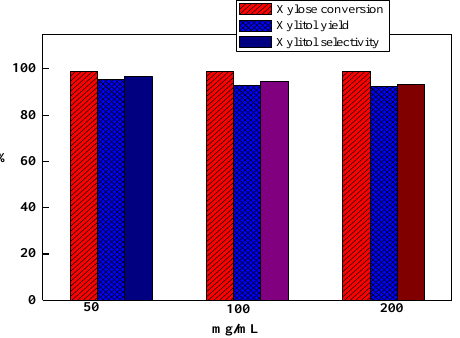
Figure 7. Effect of xylose concentration on the conversion of xylose, the xylitol yield, and the selectivity toward xylitol over Ni-Re / AC (n Ni :n Re = 1:1). Reaction conditions: 20 mL deionized water, 0.1 g Ni Re catalyst, 2 MPa of H 2 , and 140 ◦ C for 1 h. Table 3. Summary of the catalytic hydrogenation of xylose to xylitol with various catalysts. Catalyst Tem. ( ◦